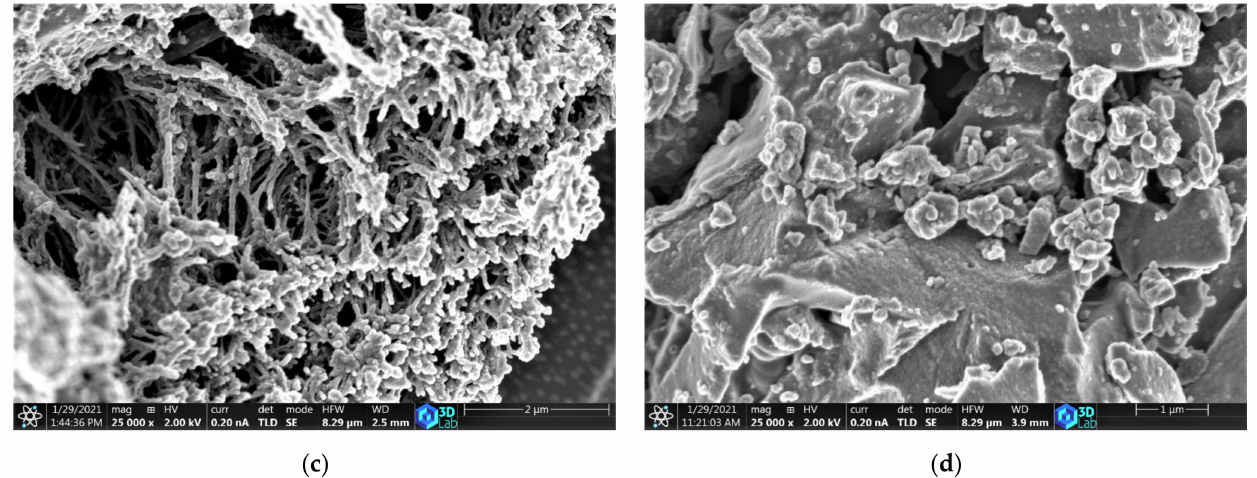
Figure 2. SEM micrographs of ( a ) ACF-G10; ( b ) ACF-G20; ( c ) ACF-G30; and ( d ) AC-X.